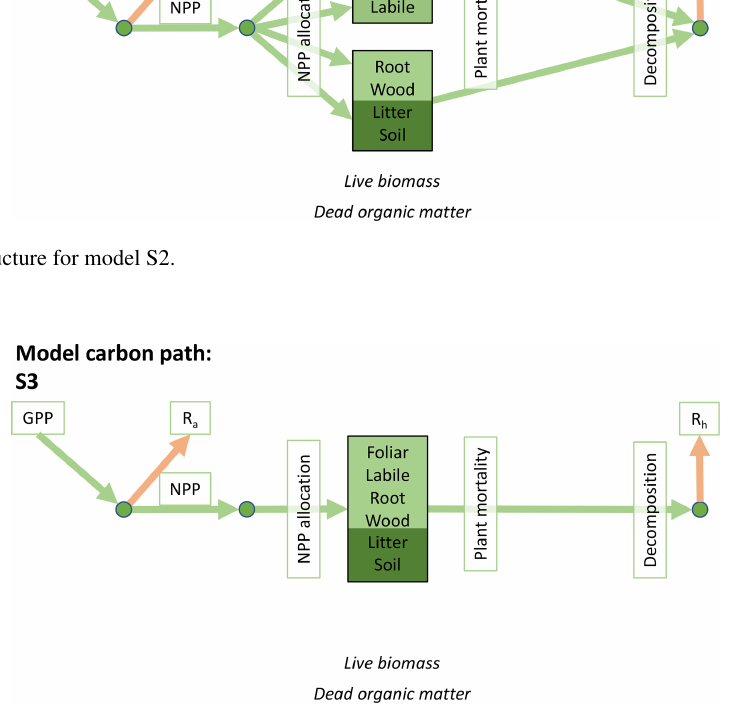
Figure B6. Carbon cycle structure for model S3.